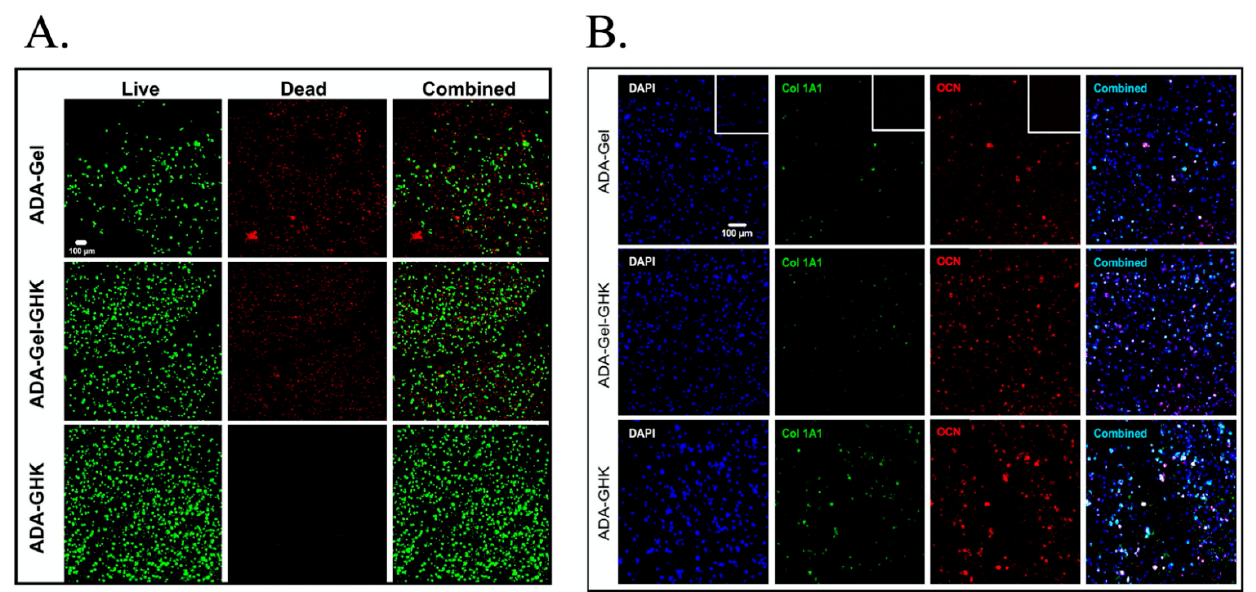
Figure 1. Confocal microscopy images demonstrating umbilical cord blood stem cells encapsulated in different hydrogels with oxidised alginate (ADA), with and without gelatine (Gel) or the GHK peptide (GHK). Confocal microscopy was able to assess the viability in different groups with the use of calcein AM ( A ), as well as the expression of proteins related to osteogenic differentiation ( B ), such as collagen type I (Col1A1) and osteocalcin (OCN). Images were adapted/reprinted from Acta Biomaterialia , 88: 224–240, Klontzas ME et al., Oxidized alginate hydrogels with the GHK peptide enhance cord blood mesenchymal stem cell osteogenesis: A paradigm for metabolomics-based evaluation of biomaterial design (2019) [16], https://doi.org/10.1016/j.actbio.2019.02.017, with permission from Elsevier.